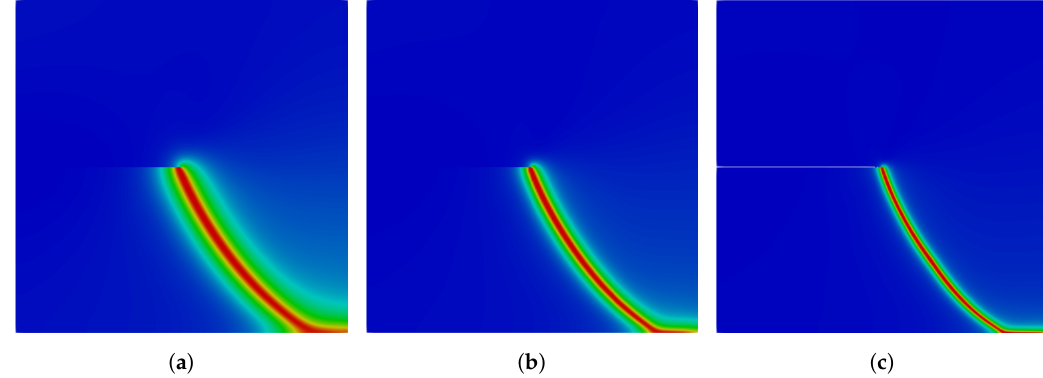
Figure 21. Shear test comparison of phase field diffusion widths with respect to decreasing l o , where